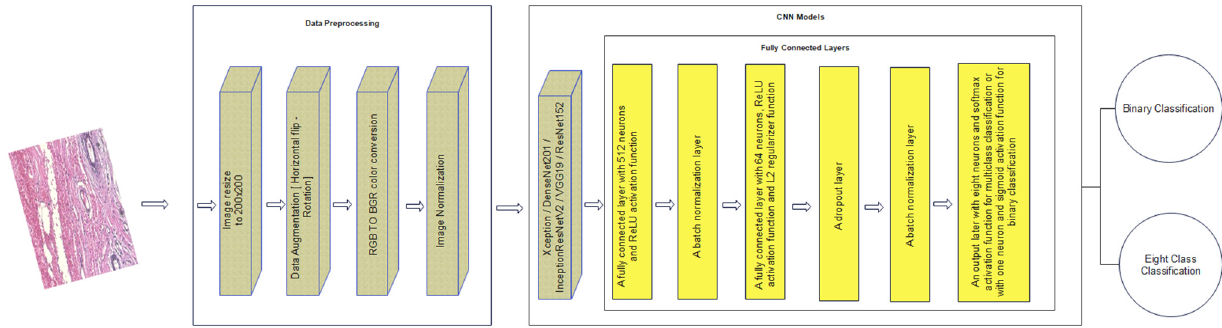
Figure 10. Architecture of the proposed approach including the data pre-processing stage and the designed fully connected layers.